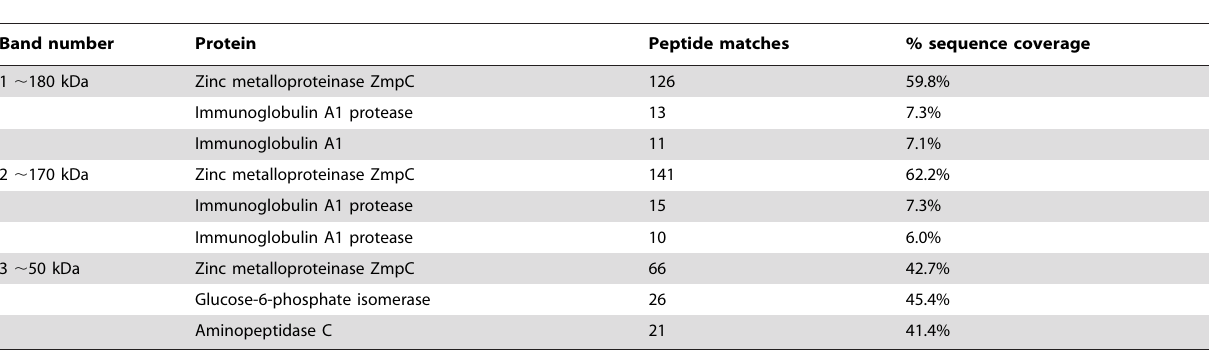
Table 1. Mass spectroscopic analysis of the purified SP168 sheddase identified as metalloproteinase ZmpC.